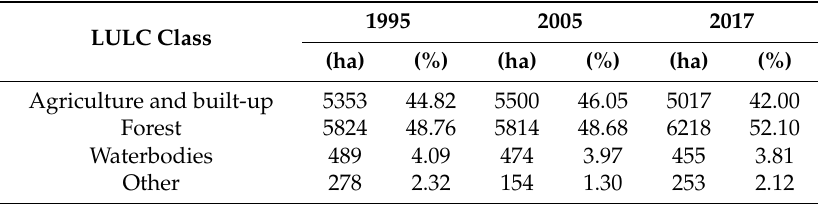
Table 4. Summary of Landsat classification area statistics for 1995, 2005 and 2017 in hectares (ha) and proportion of the total landscape